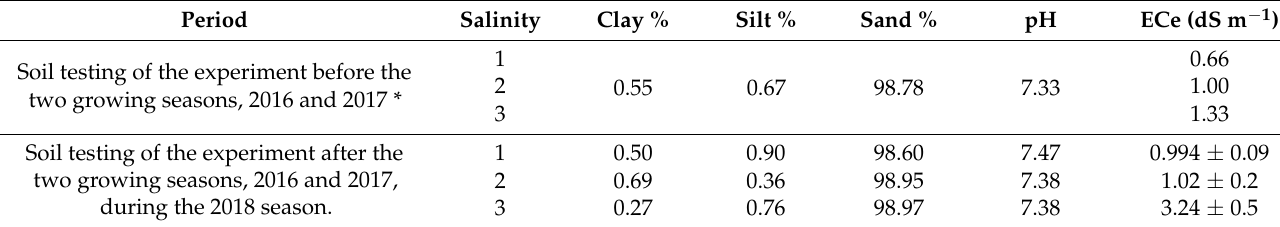
Table 5. Soil properties before and after the growing season